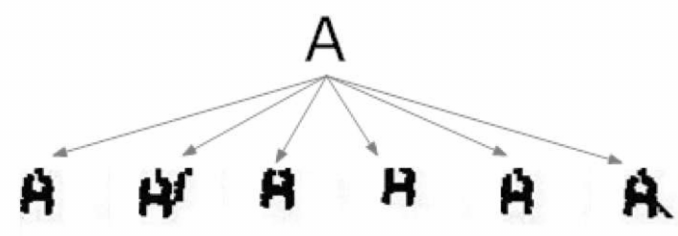
Figure 8. The morphological family of character